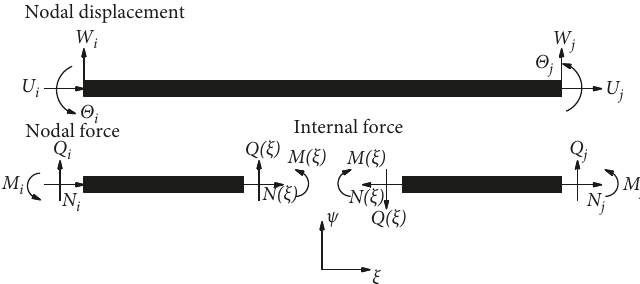
Figure 5: Sign convention for a Bernoulli–Euler beam element.